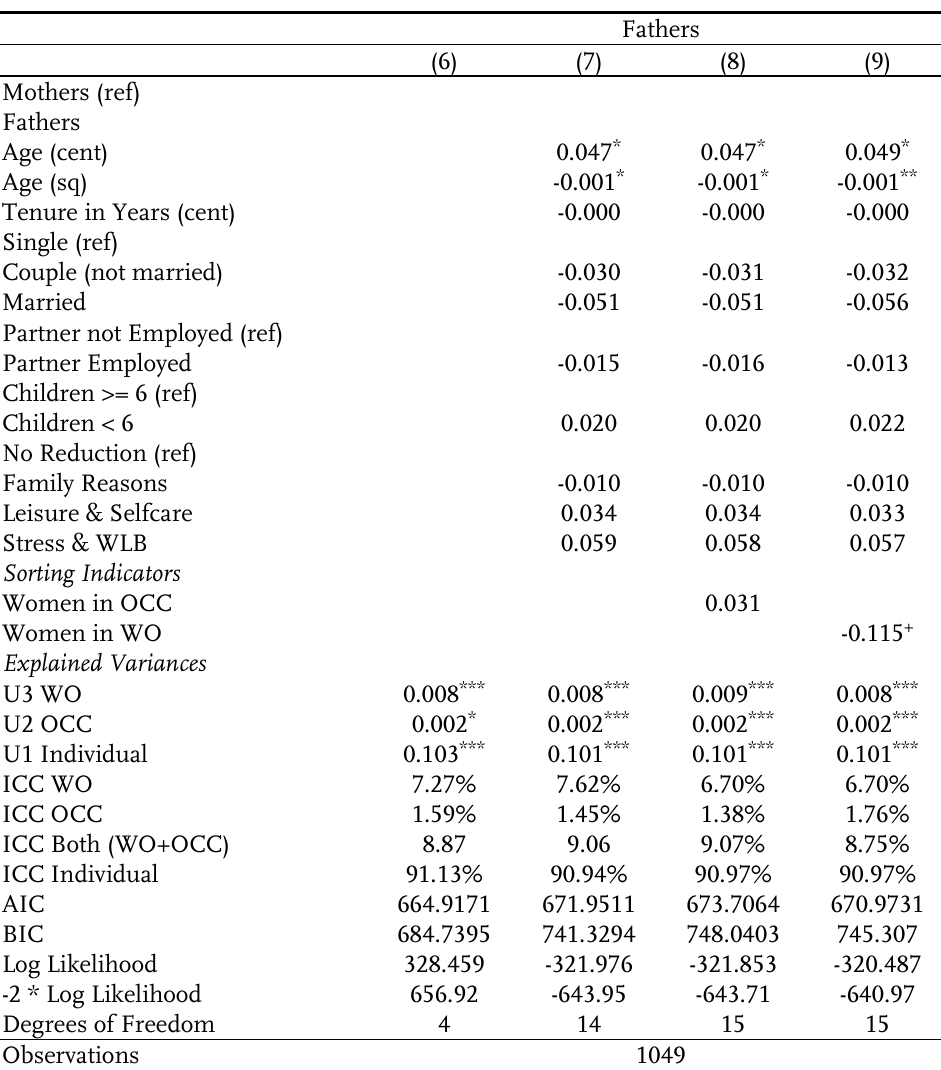
Table 3 : Cross-classified multilevel model on reduction of contracted work